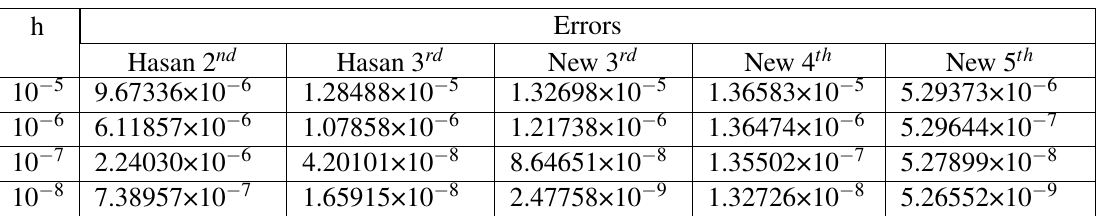
Table 4.2 (b): Absolute errors of the solution of Eq. (22) at x = 0 . 0001 by Hasan’s [13, 16] methods and new methods with Romberg